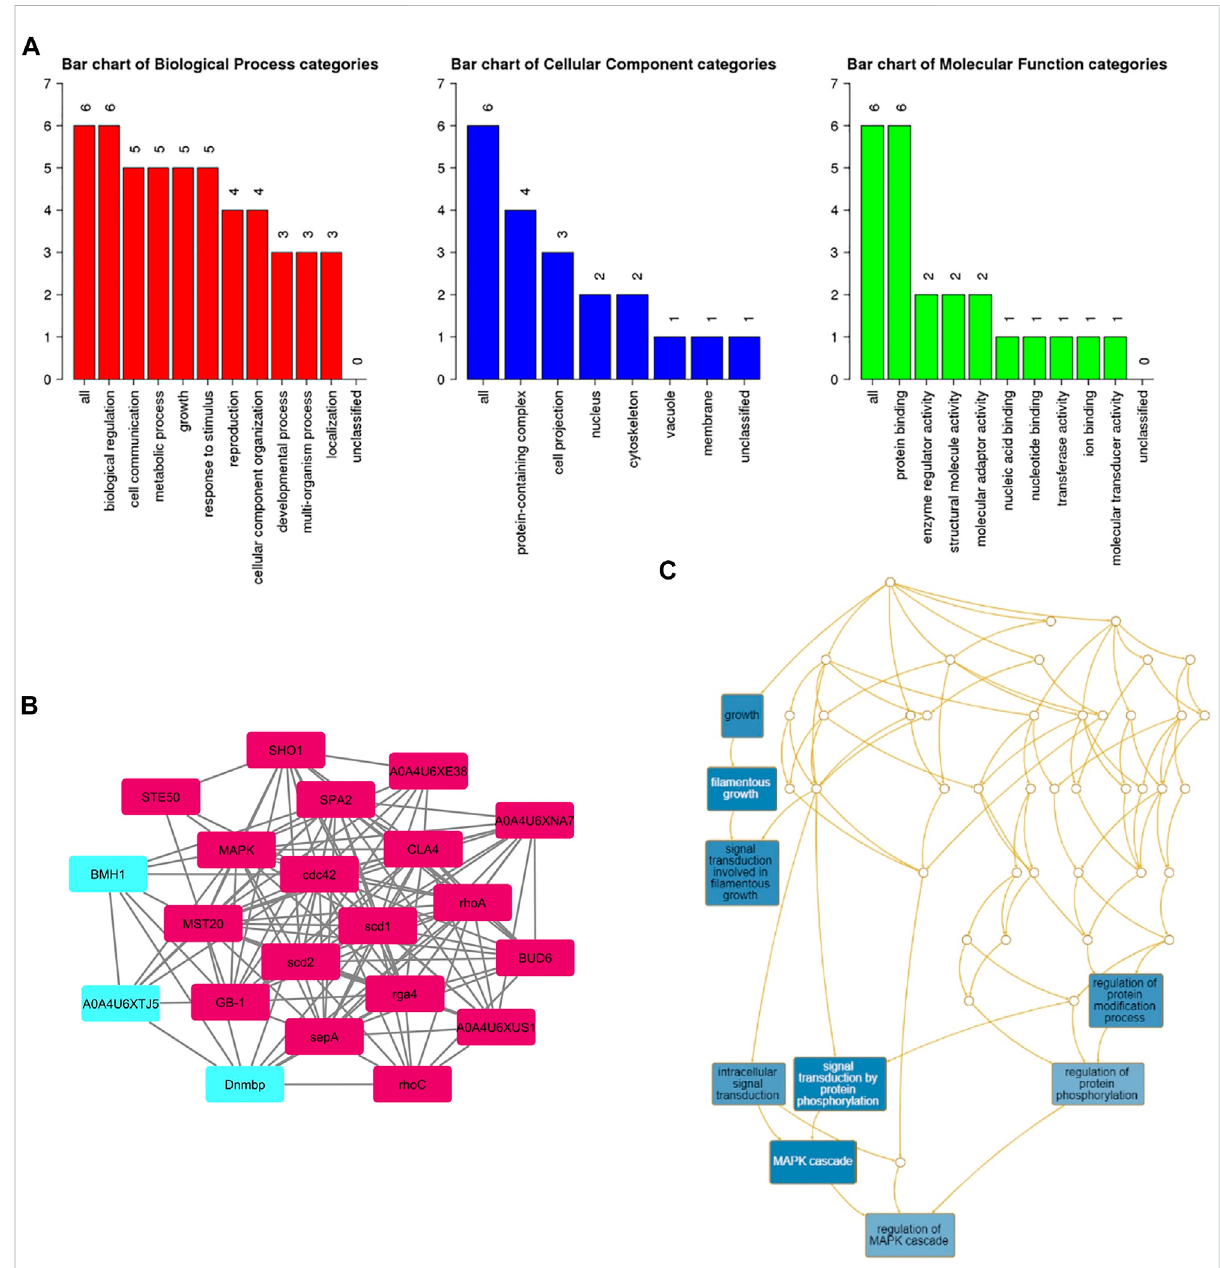
FIGURE 5 (A) Gene ontology analysisrepresents role of proteins in different process such as biological process, cellular and molecular function. The number of proteins involved in different process were represented above each bar. (B) node attribute enumerator analysis using MCODE available with Cytoscape (Maroon color subnetwork- 1; Cyan subnetwork-2); The subnetwork 1 is occupied with maximum numbers of proteins and subnetwork 2 is occupied with 3 proteins (C) Subnetworks - three clusters are highlighted in blue and the functional involvement of three clusters are represented in white